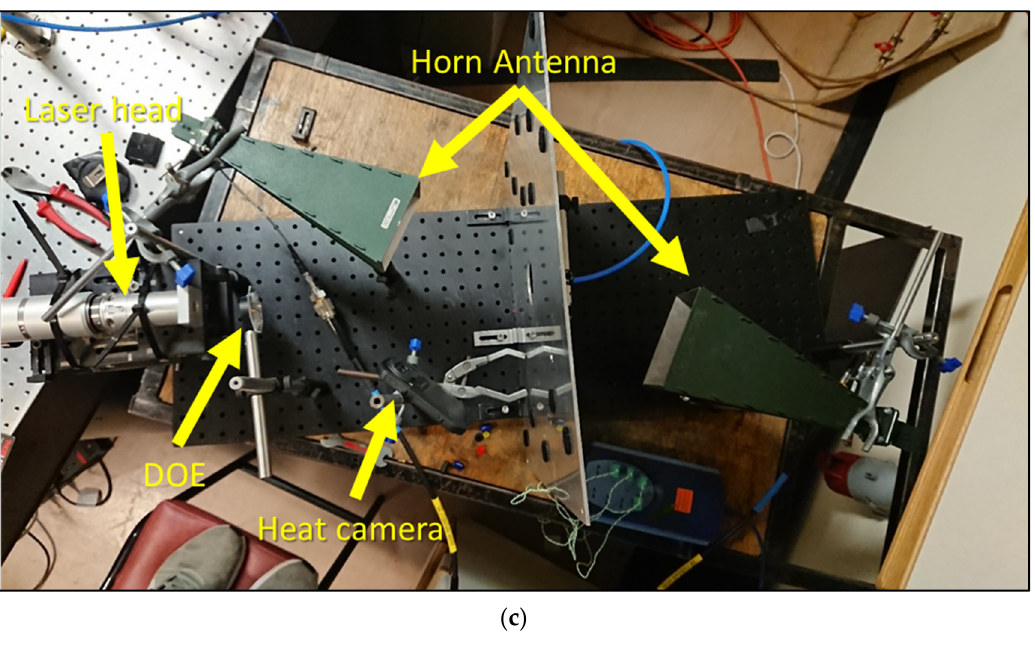
Figure 1. ( a ) Experimental setup in the lab. ( b ) Schematic of the measurement setup. ( c ) Elevated view of experimental setup in the lab.